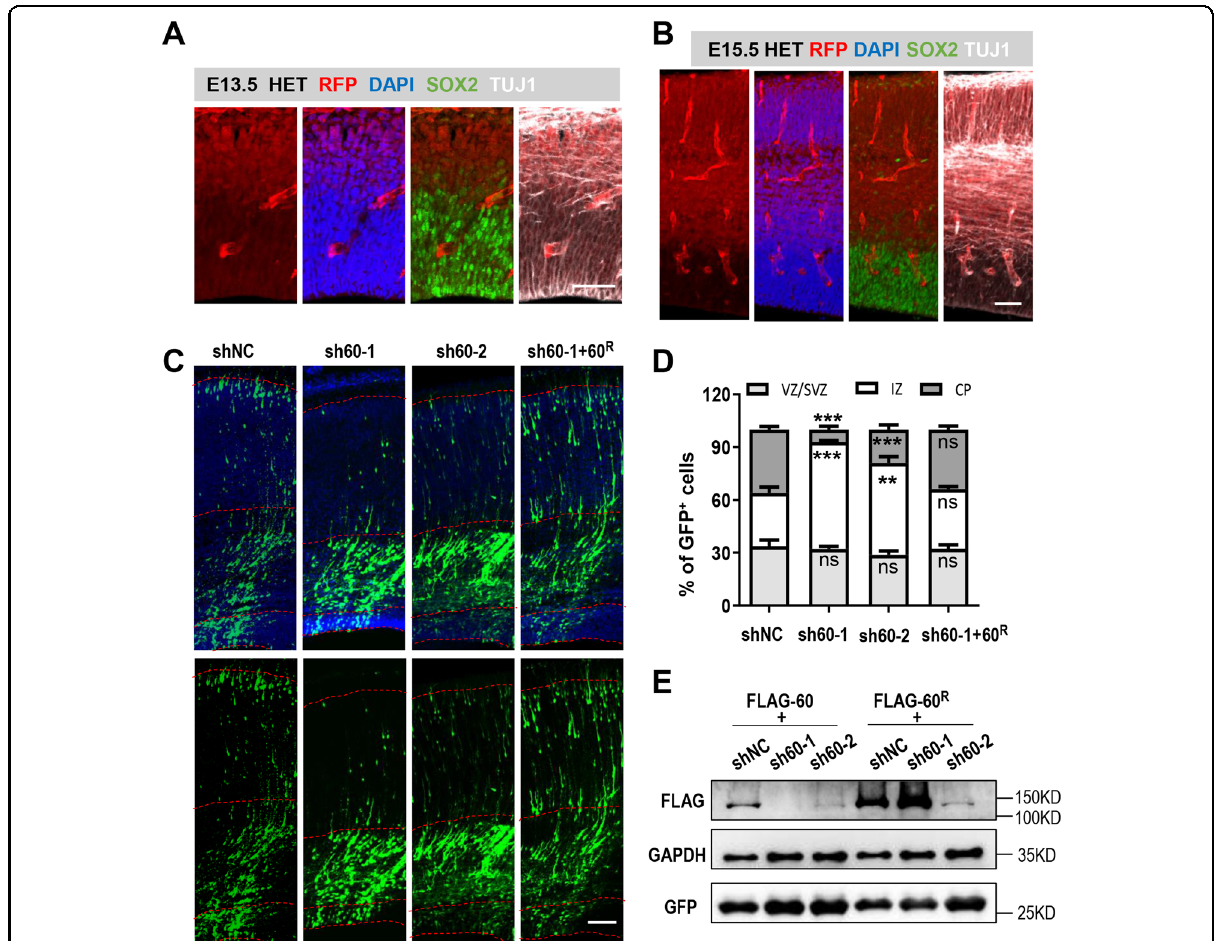
Fig. 1 WDR60 is expressed in the developing neocortex and essential for neural migration. a , b Images of cortex slices from E13.5 ( a ) and E15.5 ( b ) Wdr60 HET mice immunostained for SOX2 (red), TUJ1 (white) and DAPI (blue). Scale bar, 50 µm. c Images of rat cortical sections electroporated in utero with the indicated constructs at E16.5 and examined at E20.5. Scale bar, 100 µm. d Quanti fi cation of the distribution of EGFP + cells in E20.5 cortical sections. n: 6 slices from 3 mice. e Indicated constructs were transfected into HEK293T cells. 48 h later, cell lysates were collected for verifying knockdown ef fi ciency of shRNAs and the resistant of Wdr60 R to sh60-1. All data are means ± SEM, t -test. ** p < 0.01, *** p <